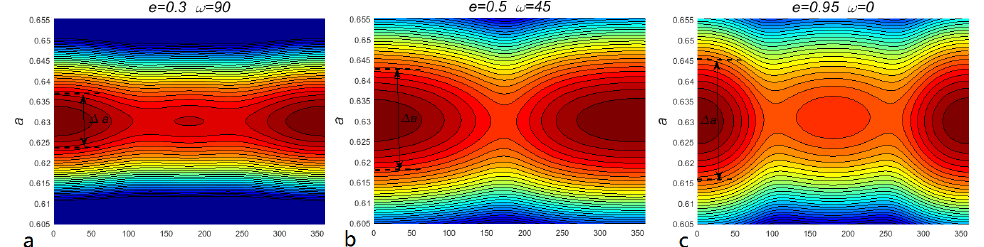
Figure 3. Phase-space portraits of 2/1 polar resonance in a − σ plane under three different sets of parameters ( e , ω ) (plane ( a ): e = 0.3, ω = 90 ◦ ; plane ( b ): e = 0.5, ω = 45 ◦ ; plane ( c ): e = 0.95, ω = 0 ◦ ). The variances of the color and contours represent the level of the averaged Hamiltonian in Equation (4). ∆ a is the resonant width of dominated libration